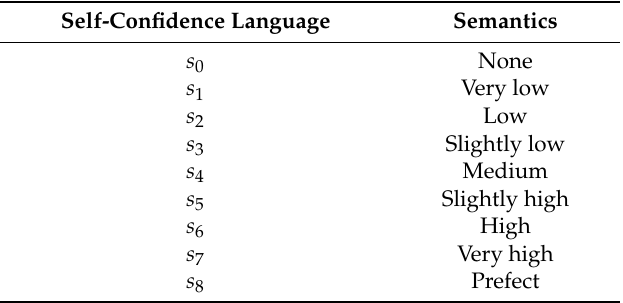
Table 2. Nine self-confidence language terms with its semantics. Self-Confidence Language Semantics s